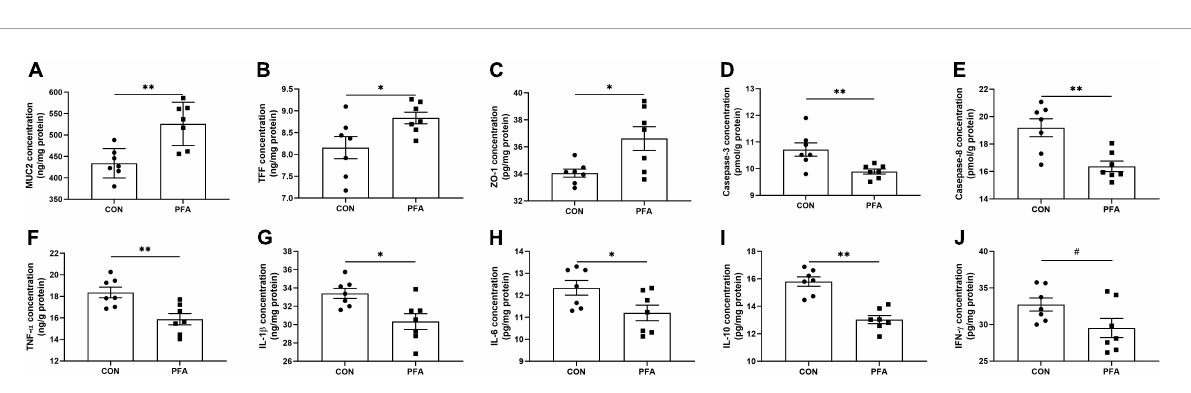
FIGURE2 Effects of dietary paraformic acid supplementation on intestinal mucosal barrier functions, apoptosis regulators, and inflammatory factors concentrations in broiler chickens. (A) Mucin (MUC2); (B) Trefoil factor family (TFF); (C) Zonula occludens-1 (ZO-1); (D) Caspase-3; (E) Caspase-9; (F) Tumor necrosis factor-alpha (TNF- α ); (G) Interleukin-1beta (IL-1 β ); (H) Interleukin-6 (IL-6); (I) Interleukin-10 (IL-10); (J) Interferon- γ (IFN- γ ). CON, broiler chickens fed basal diet; PFA, broiler chickens fed basal diet supplemented with 1,000 mg/kg paraformic acid. Values are mean ± standard error ( n = 7). Differences between treatments were displayed by # 0.05 ≤ P < 0.10, ∗ P < 0.05, and ∗∗ P < 0.01.